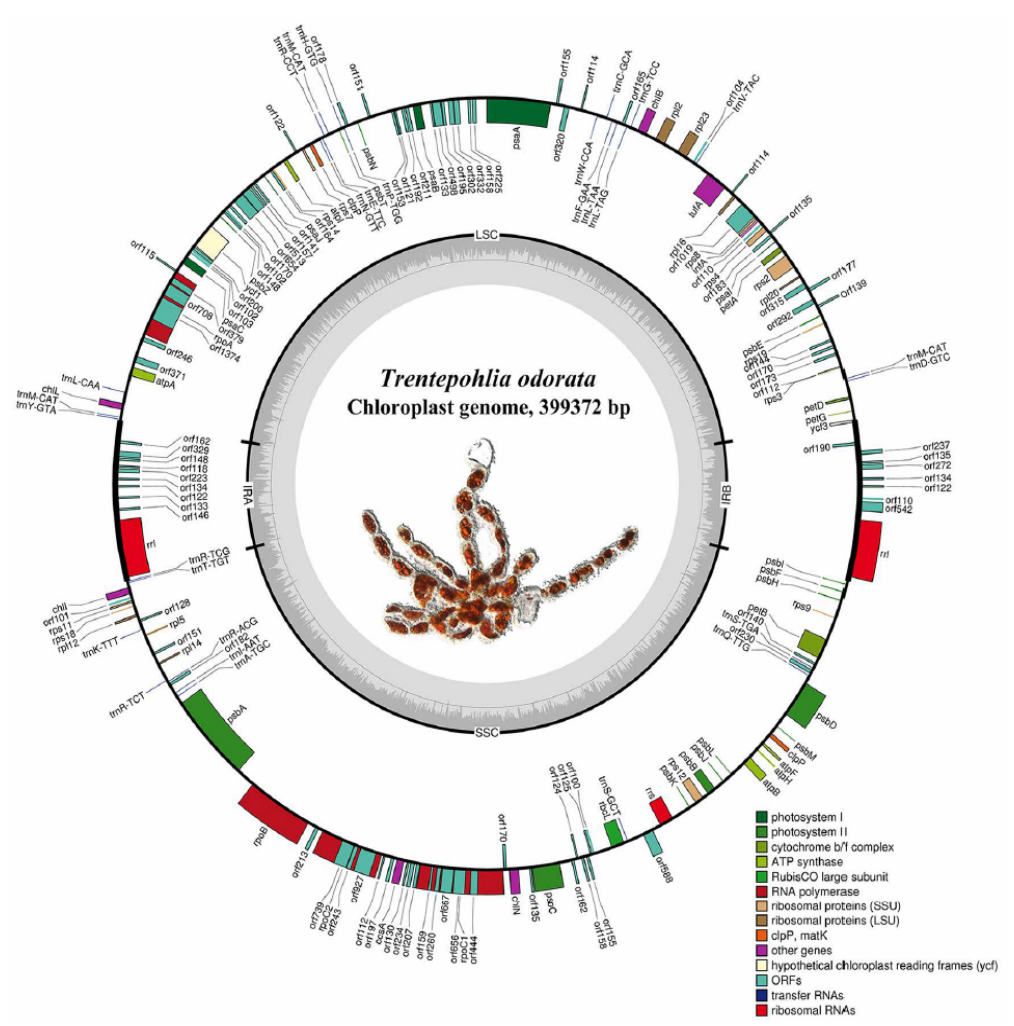
Figure 5. Circular map of the chloroplast genome of the Trentepohlia odorata (MK580484). Genes are color coded according to the functional categories listed in the index below the map. The GC content and inverted repeats (IRA and IRB) which separate the genome into two single copy regions are indicated on the inner circle. Genes on the inside of the outside circle are transcribed in a clockwise direction; those on the outside of the map are transcribed counterclockwise.